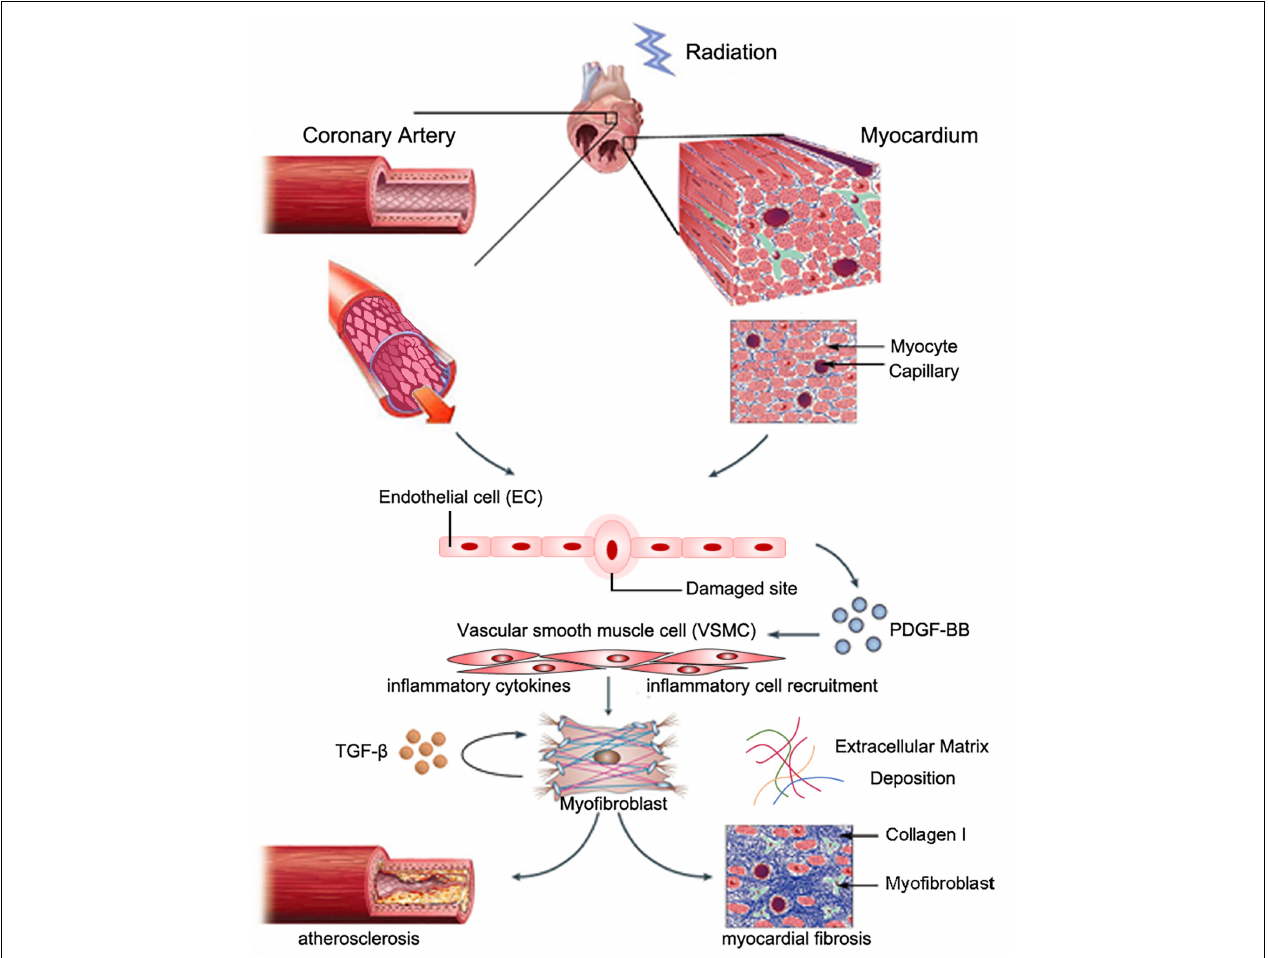
FIGURE 1 | Possible role of VSMCs in radiation-induced cardiac fibrosis. Partially reproduced with permission from Weintraub et al. (2010).